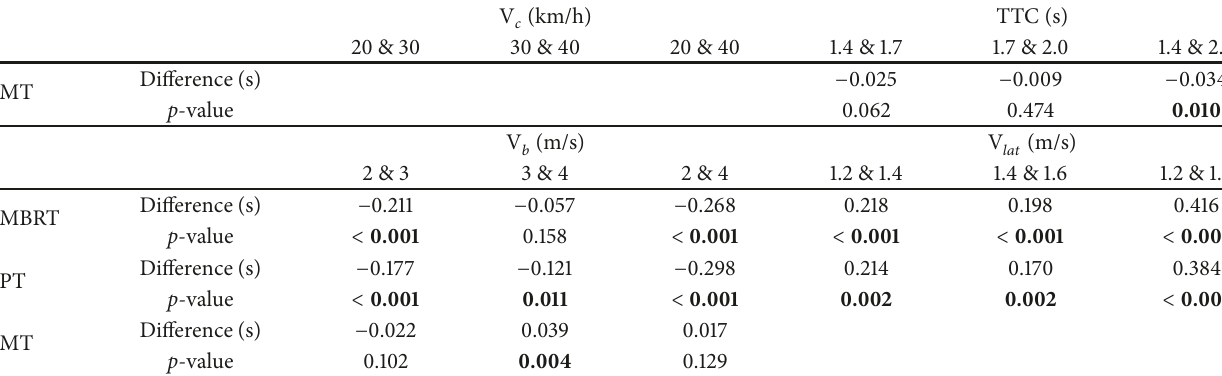
∗∗ ∗ ∗ Figure 6: The average ( ± SD) of MBRT, PT, and MT at three levels of the four parameters in SSR. Table 5: Post hoc analysis for MBRT, PT, and MT in